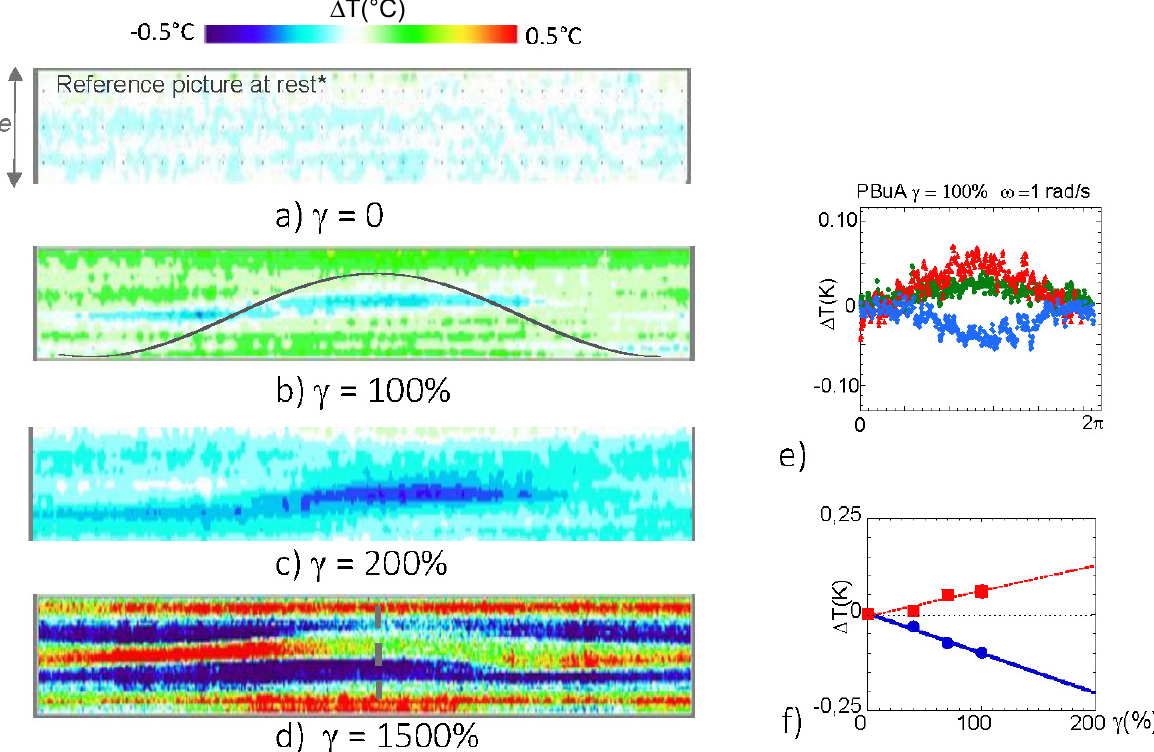
Figure 2. Time evolution of temperature cartography of the low molecular weight polymer melt (PBuA–Mn = 40,000) at rest ( a ) and along one oscillatory period ( ω = 1 rad/s)( b – d ) submitted to an oscillatory shear strain (280 µm gap, alumina surfaces, room temperature measurements). The upper plane was fixed while the bottom one oscillated. The continuous line of ( b ) is an eye-guide of the sin strain function. ( a ) γ = 0%, ( b ) γ = 100%, ( c ) γ = 200%, ( d ) γ = 1500%. ( e ) Temperature profiles over one oscillatory period in the central part (blue points) and on each side of the gap (bottom (red) and upper (dark green) bands) at 100% shear strain and 1 rad/s (the profiles are determined in horizontal bands centered on the highest, the lowest and the medium temperature zones). ( f ) Evolution of the temperature variation ( ∆ T = T − T γ =0 ) of the cold ( • ) and of the hot zones ( (cid:4) ). The large strain value ( γ = 1500%) is not represented due to the occurrence of multiple thermal bands.